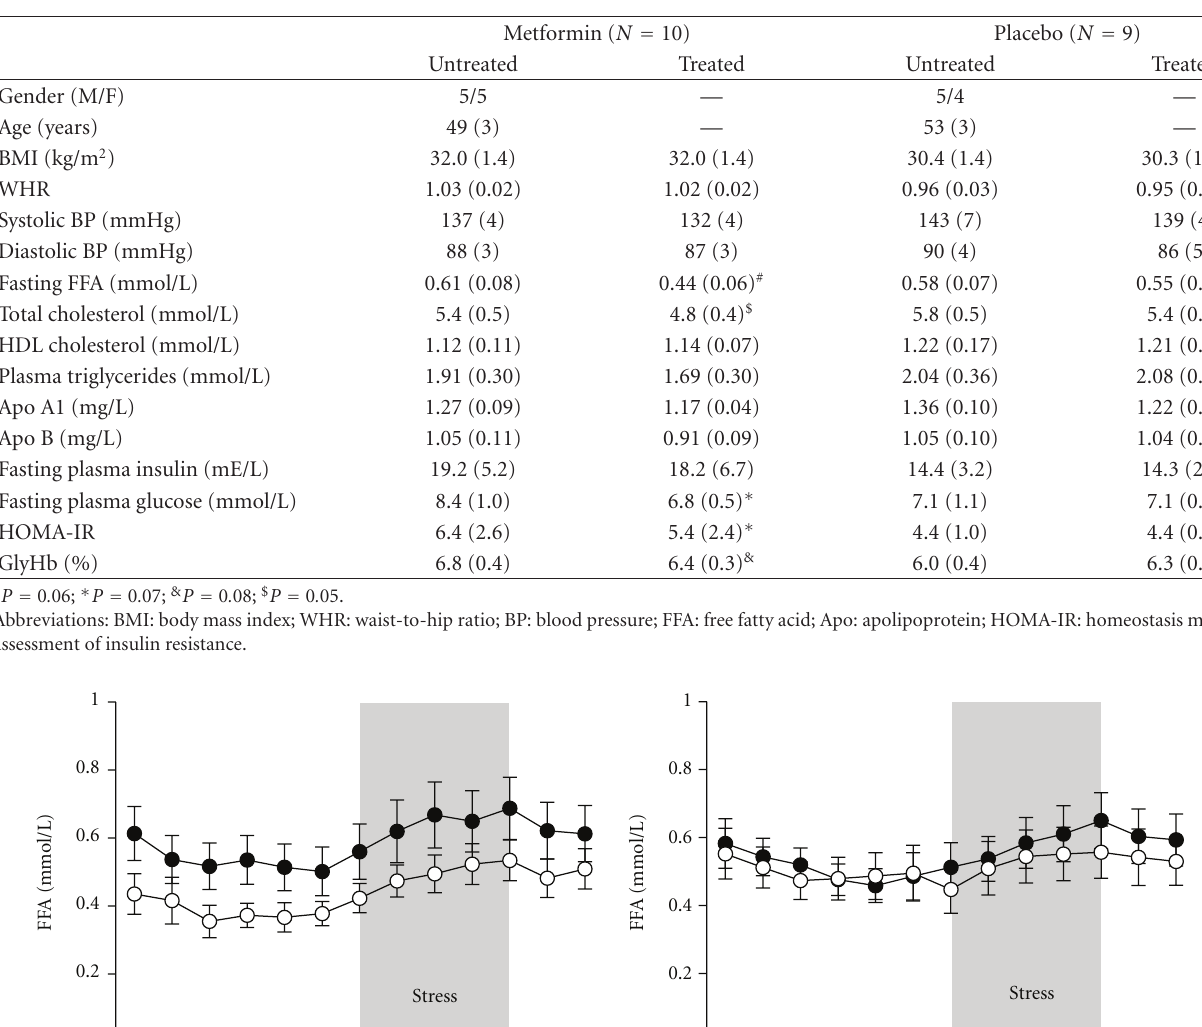
0 . 44 ± 0 . 06 mmol/L ( P = 0 . 06) in contrast to placebo